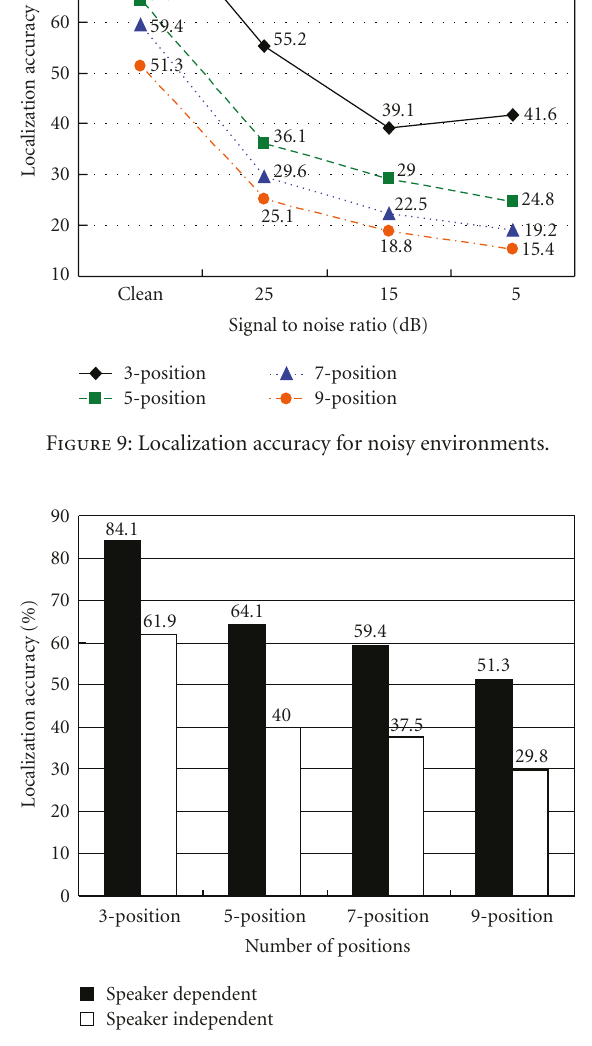
Figure 10: Comparison of performance using speaker-de- pendent/independent speech model (speaker-independent, 256 Gaussian mixture components; speaker-dependent, 64 Gaussian mixture